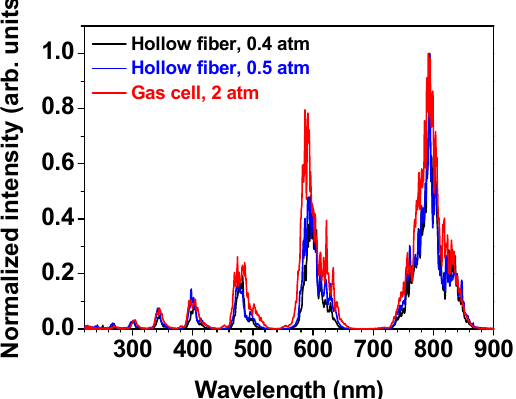
Figure 7. Spectra of the output beam from the hollow fiber at 0.4 atm (black solid line) and 0.5 atm (blue solid line) and the gas cell (red solid line) at 2 atm. The spectrum is normalized by the intensity of the highest